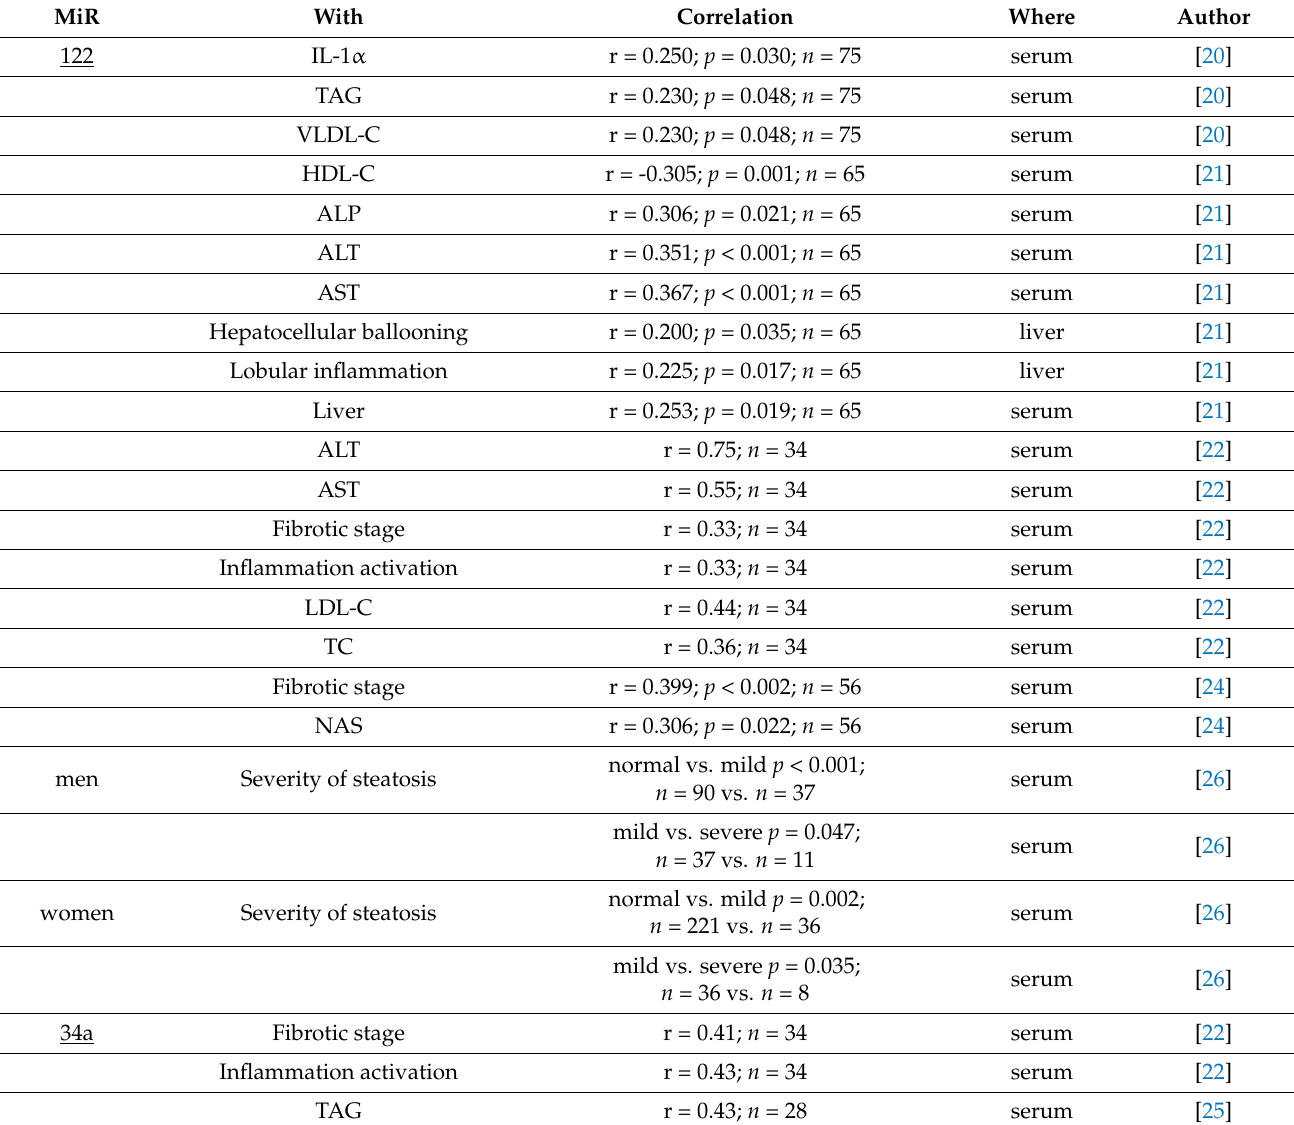
Table 2. Correlations between miRNA and NASH-related